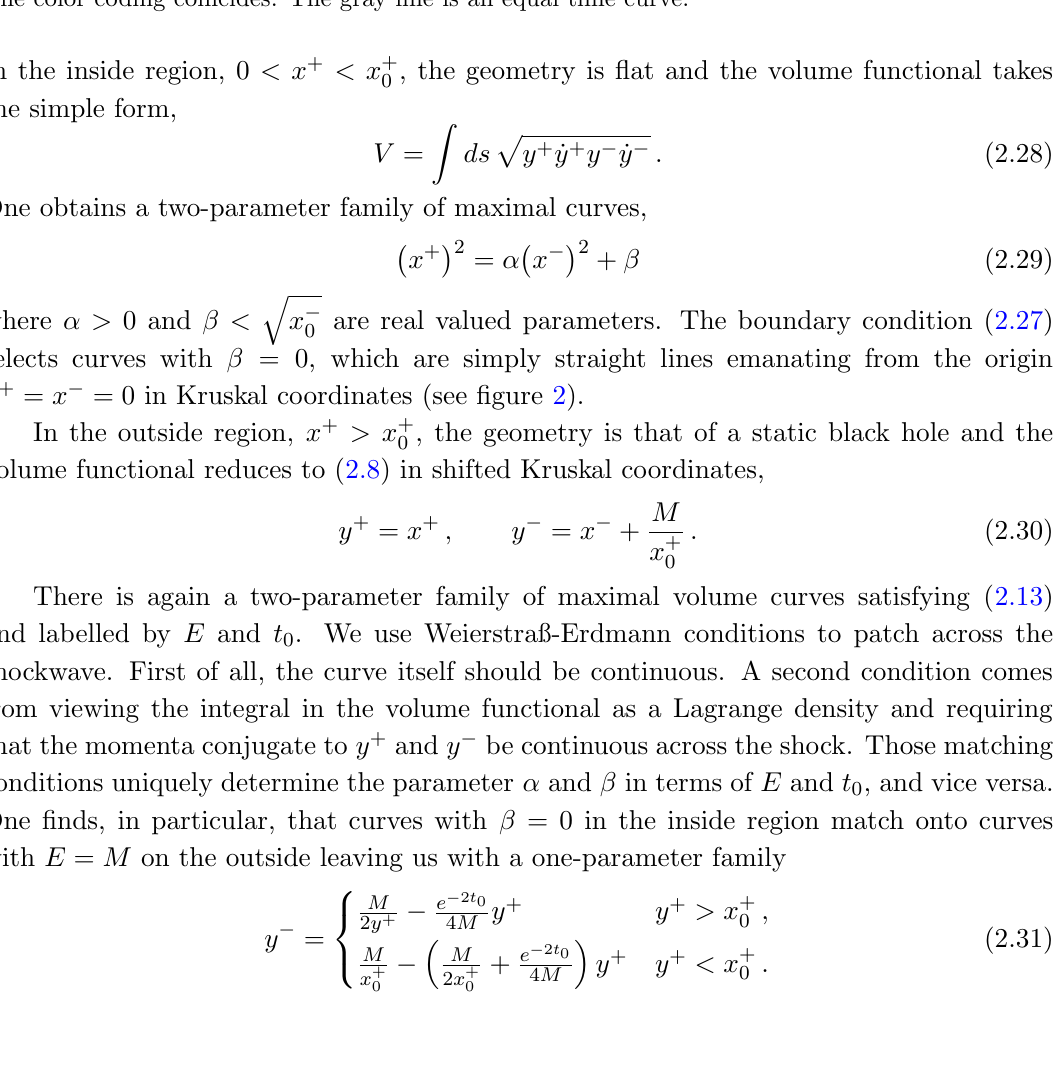
Figure 2 . ( Left ) This cartoon depicts the Penrose diagram of a one-sided CGHS black hole formed by gravitational collapse. ( Right ) This is a Kruskal diagram of the Penrose diagram on the left. The color coding coincides. The gray line is an equal time